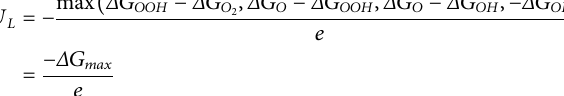
Frontiers in Chemistry |